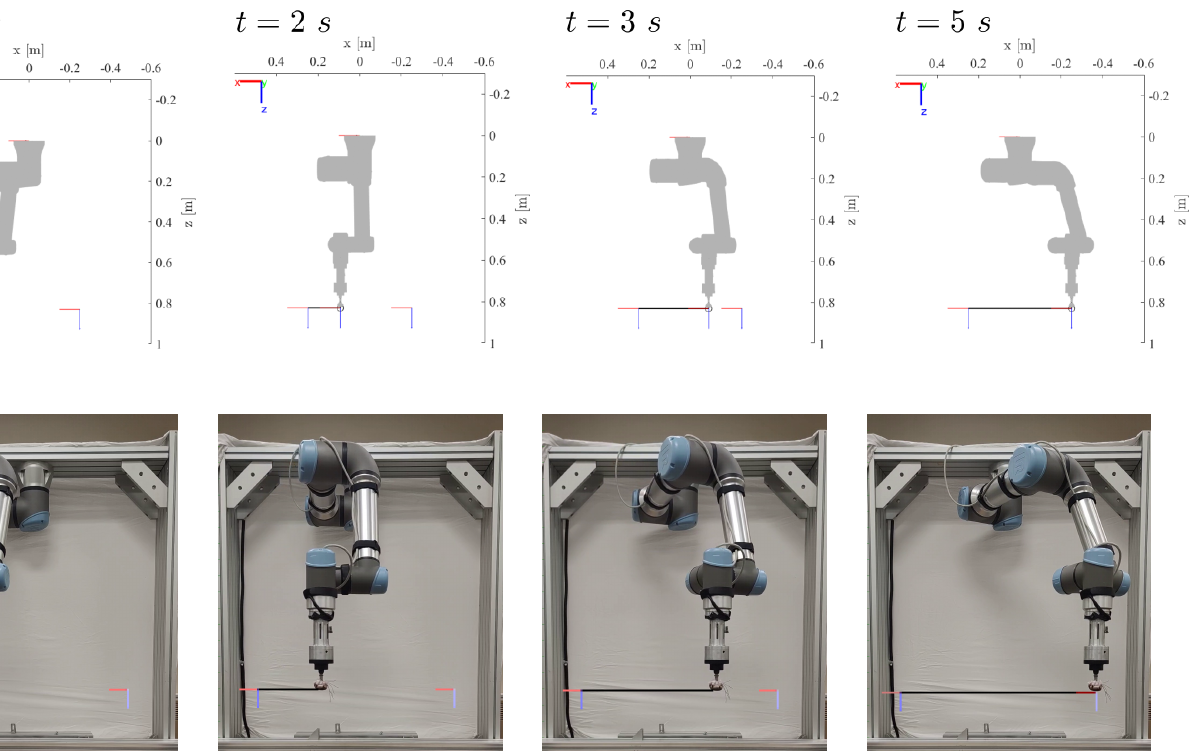
Figure 4. Test case 1: straight motion between two points, Mode I. Simulated ( top ) and real ( bottom ) motion of the robot.